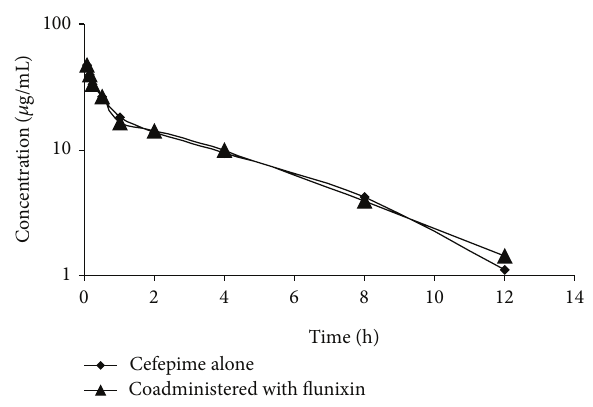
Figure 1: Serum concentrations of cefepime alone and in combina- tion with flunixin following a single intravenous injection in goats.